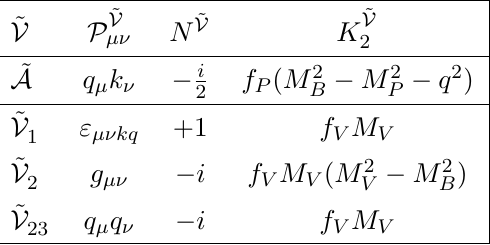
˜ Table 1 . Overview of the quantities V extracted from the correlation functions, their corresponding Lorentz structures P ˜ V , and their normalization factors N ˜ V and K ˜ V µν The quantities P ˜ V , N ˜ V , and K ˜ V are listed in table 1, while the coefficients C (˜ V ,ψ 3p ) µν 2